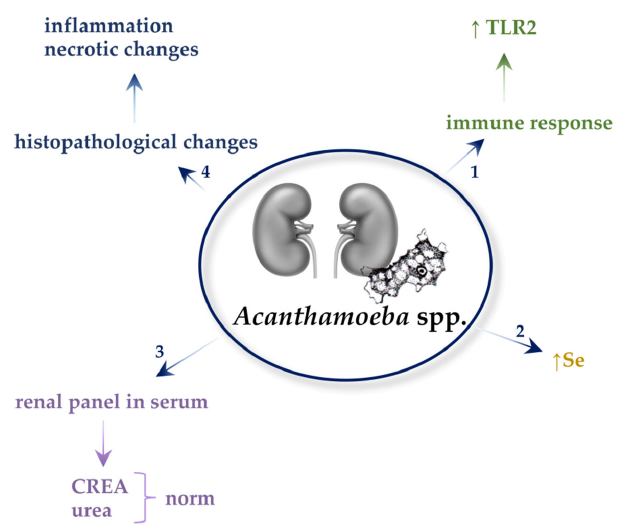
Figure 4. Mechanisms in the Acanthamoeba spp.-infected kidneys. 1. Acanthamoeba spp. increase the expression of Toll-like receptor 2 (TLR-2). 2. Acanthamoeba spp. increase selenium (Se) concentration in the kidneys of infected host. 3. Acanthamoeba spp. do not affect the levels of creatine (CREA) and urea in the serum of hosts. 4. The parasites cause inflammation and necrotic changes in the tubules and glomeruli of the kidneys.